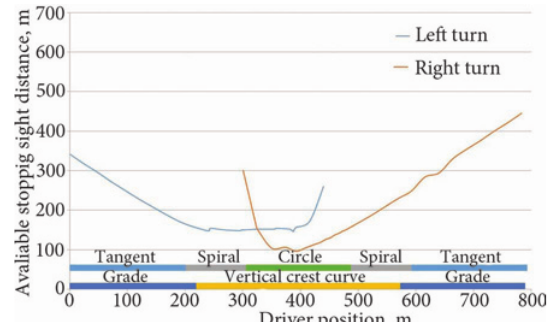
Fig. 5. Available stopping sight distance profile with lateral obstructions